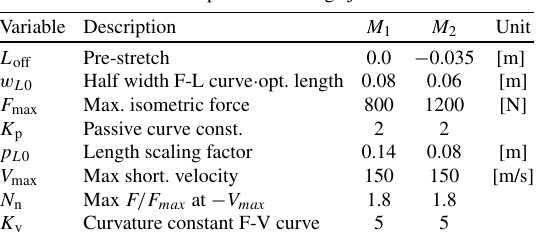
Table 2 Muscle parameters hinge